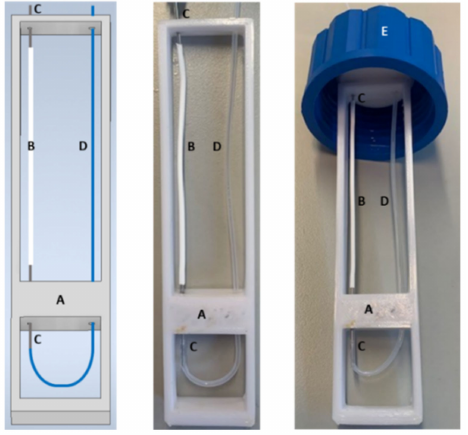
Figure 2. Support pictures of the microporous tube either designed by CAD (left) or manufactured in ABS by 3D printing. A: 3D support of the microporous tube; B: microporous tube of 7 cm long; C: bevelled stainless-steel tube serving as a connector for the microporous tube; D: 1/16-inch Teflon tube; E: GL 45 bottle